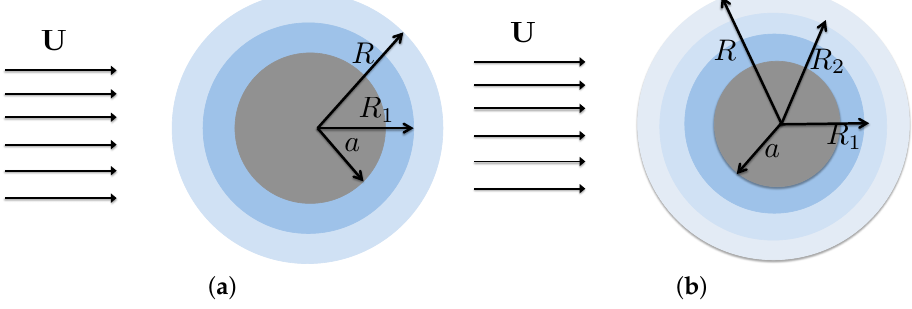
Figure 8. The uniform background flow U = U e z past a rigid sphere with a multiple-layer fluid coating. The gray region with radius a indicates the rigid kernel. The light colored regions show the fluid coating with radii R 1 , R 2 , and R for the three-layer case. ( a ) The rigid kernel covered with a two-layer fluid coating. a ≤ R 1 ≤ R ; ( b ) The rigid kernel covered with a three-layer fluid coating. a ≤ R 1 ≤ R 2 ≤ R